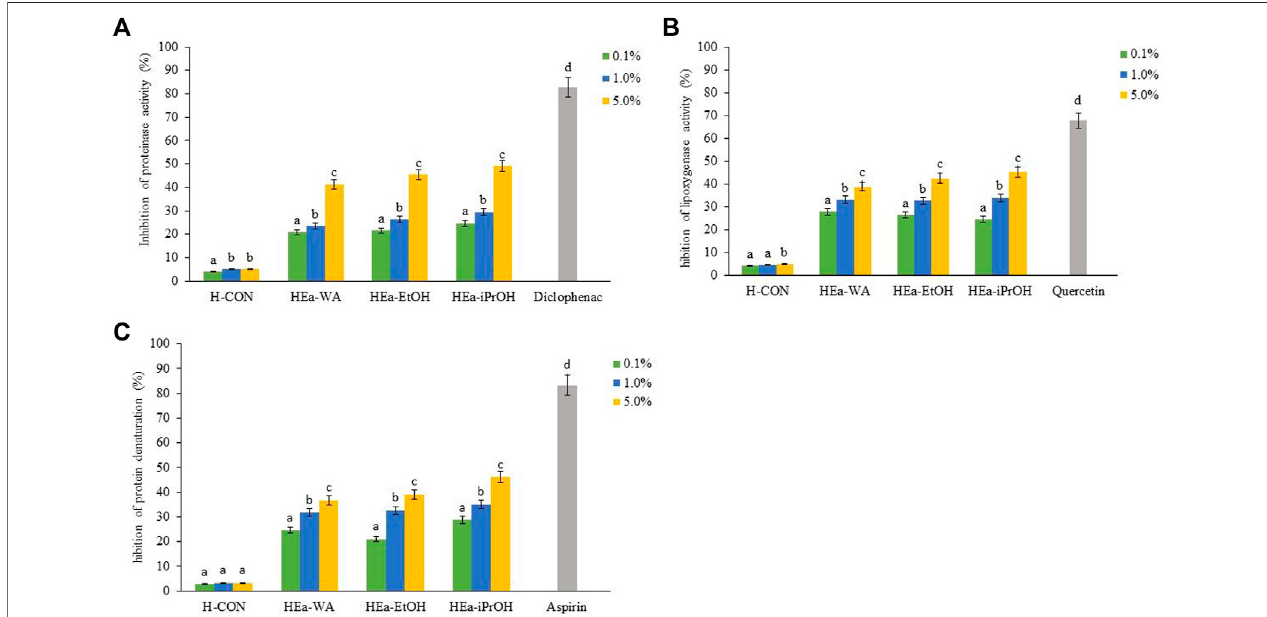
FIGURE 3 | Anti-In fl ammatory properties of HEas. The proteinase inhibition (A) , the lipoxygenase inhibition (B) , the inhibition of protein denaturation (C) . HEa- EtOH — hydrogel containing dry ethanolic extract of E. angustifolium ; HEa-iPrOH — hydrogel containing dry isopropanol extract of E. angustifolium ; HEa-WA — hydrogel containing dry water extract of E. angustifolium ; (H)CON — hydrogel without E. angustifolium extract. All hydrogels were used in 0.1, 1.0 and 5.0%. Diclofenac (A) , quercetin (B) and aspirin (C) was used as a control inhibitor. Different letters indicate signi fi cant differences between the HEas, α = 0.05. Values are the mean of three replicate determinations ( n =